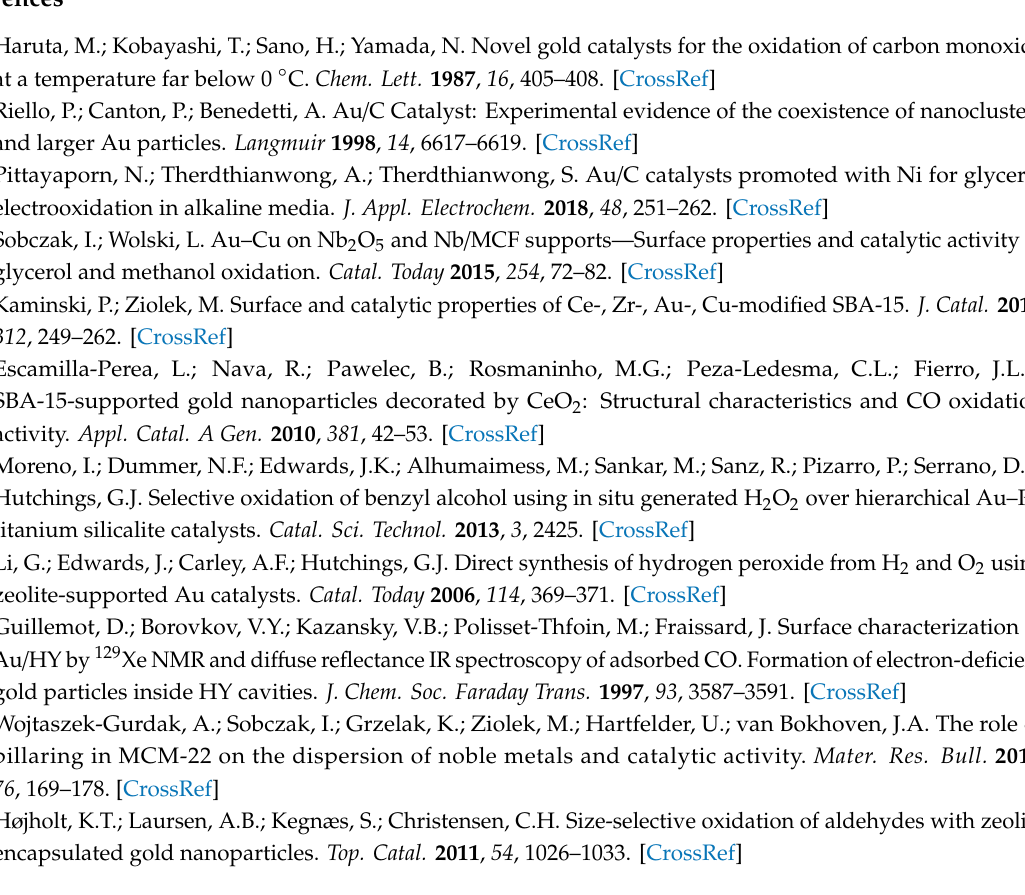
Supplementary Materials: The following are available online, Figure S1: TEM images of Au-HBeta(IE), Figure S2: TEM images of Au-HBeta(DR), Figure S3: UV-vis spectra of materials, Figure S4: The low-temperature N 2 adsorption-desorption isotherms for examined materials, Figure S5: Au 4f XP spectra of HBeta and gold-modified zeolites, Table S1: Relative contribution of individual oxygen species estimated from deconvoluted O 1s XP spectra, Figure S6: Pyridine ring vibration range of FTIR spectra recorded after adsorption (at 150 ◦ C), and desorption of pyridine (at 150, 200, 250, and 300 ◦ C), Figure S7: Variations of the amount of Py adsorbed on BAS in relation to evacuation temperature (150, 200, 250, and 300 ◦